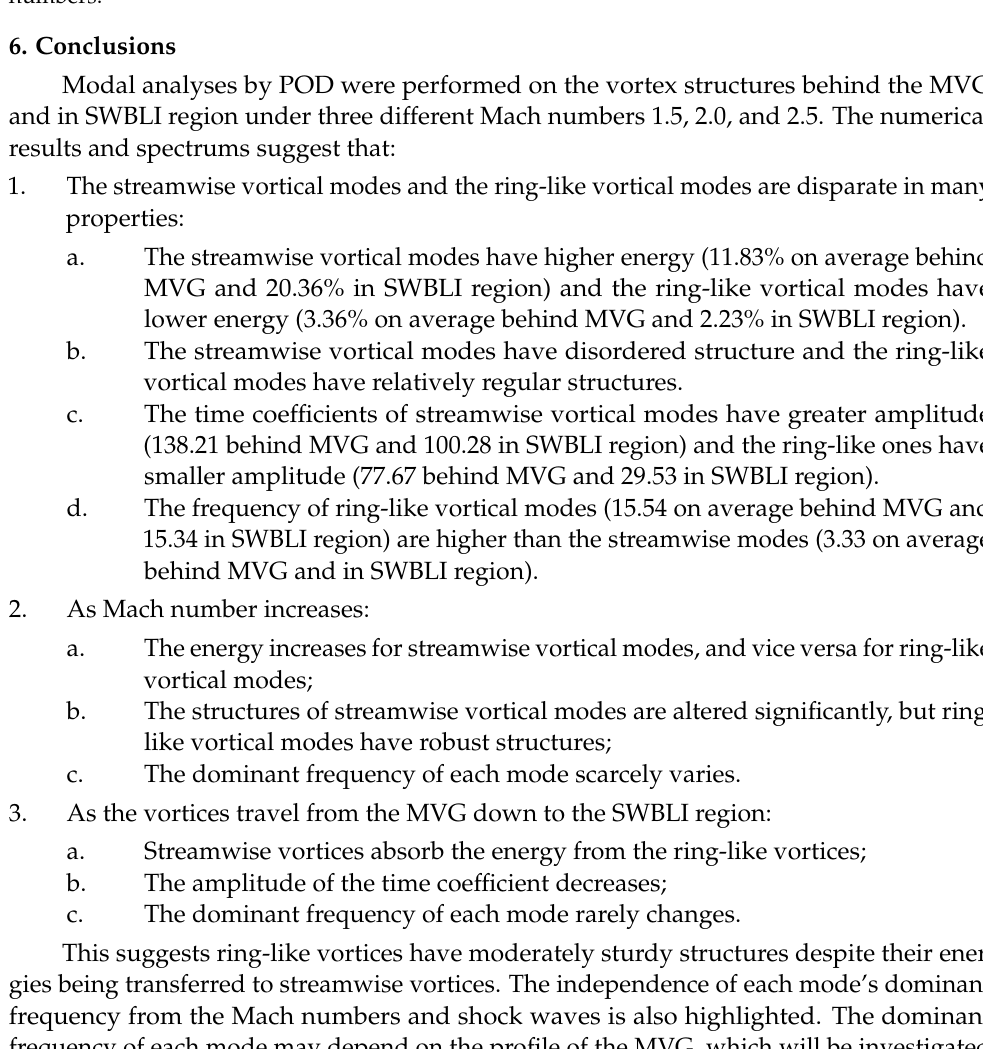
Figure 16. The dominant frequency of the first 20 modes in the SWBLI region in three different Mach